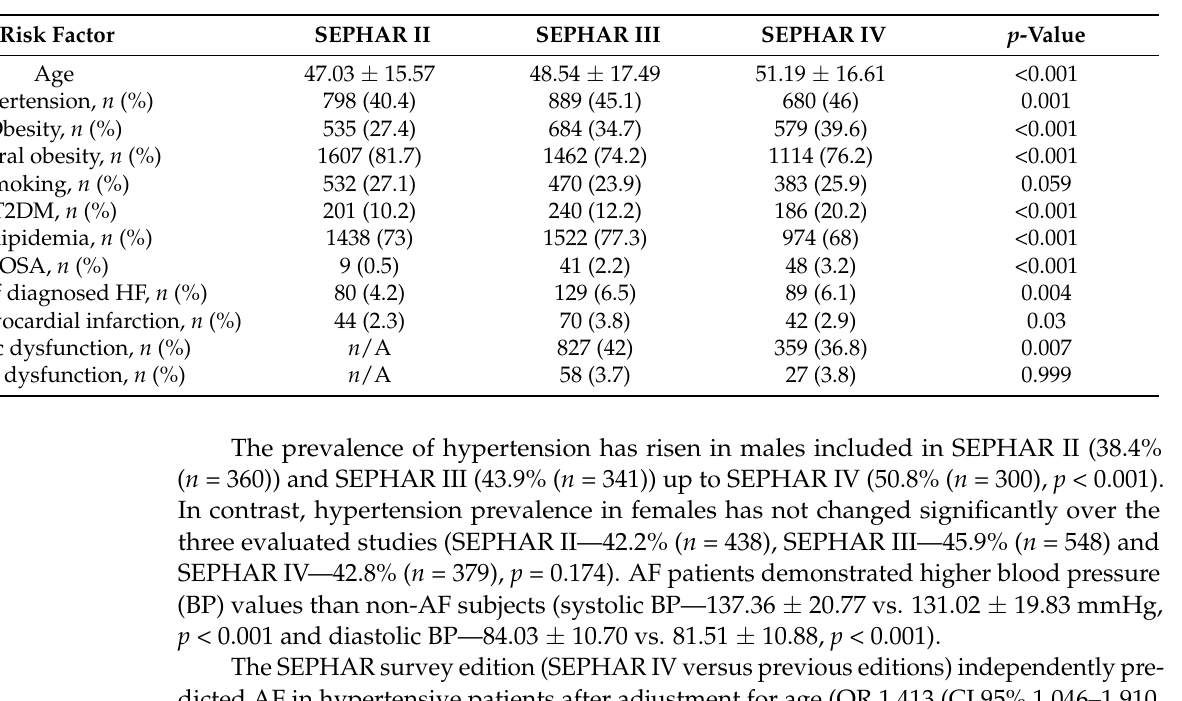
Table 3. Trends in AF-inducing risk factors in SEPHAR II, SEPHAR III and SEPHAR IV surveys. T2DM = type 2 diabetes mellitus, OSA = obstructive sleep apnea, HF = heart